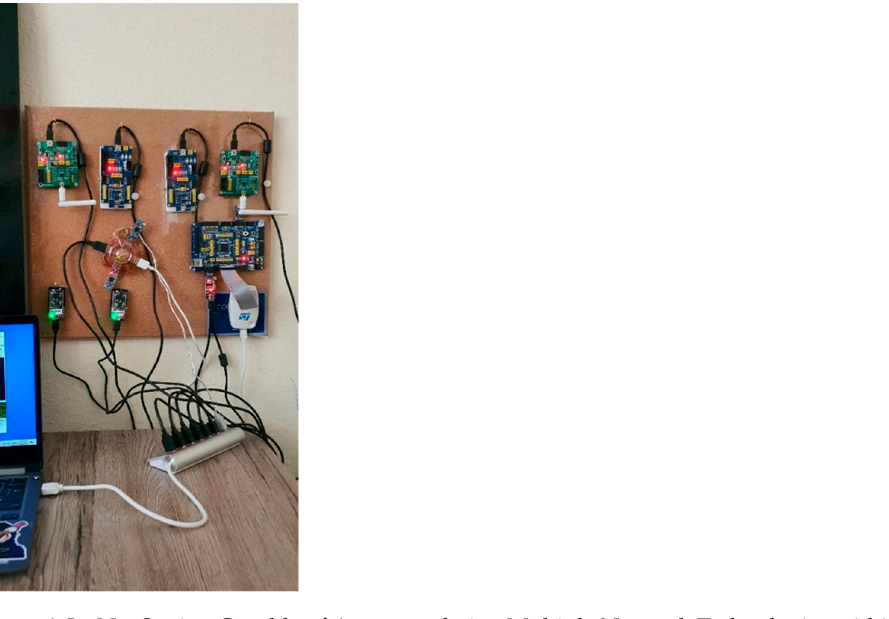
Figure 12. Communication between the BL1 node and ZB1 node.